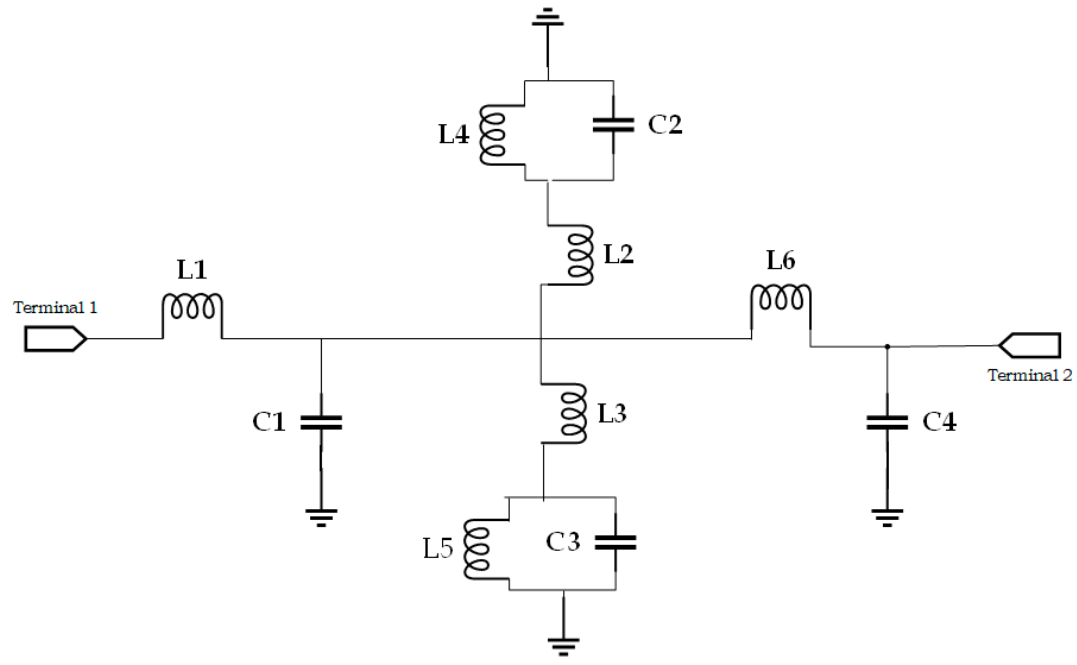
Figure 2. Equivalent circuit model for proposed metamaterial-based sensor.